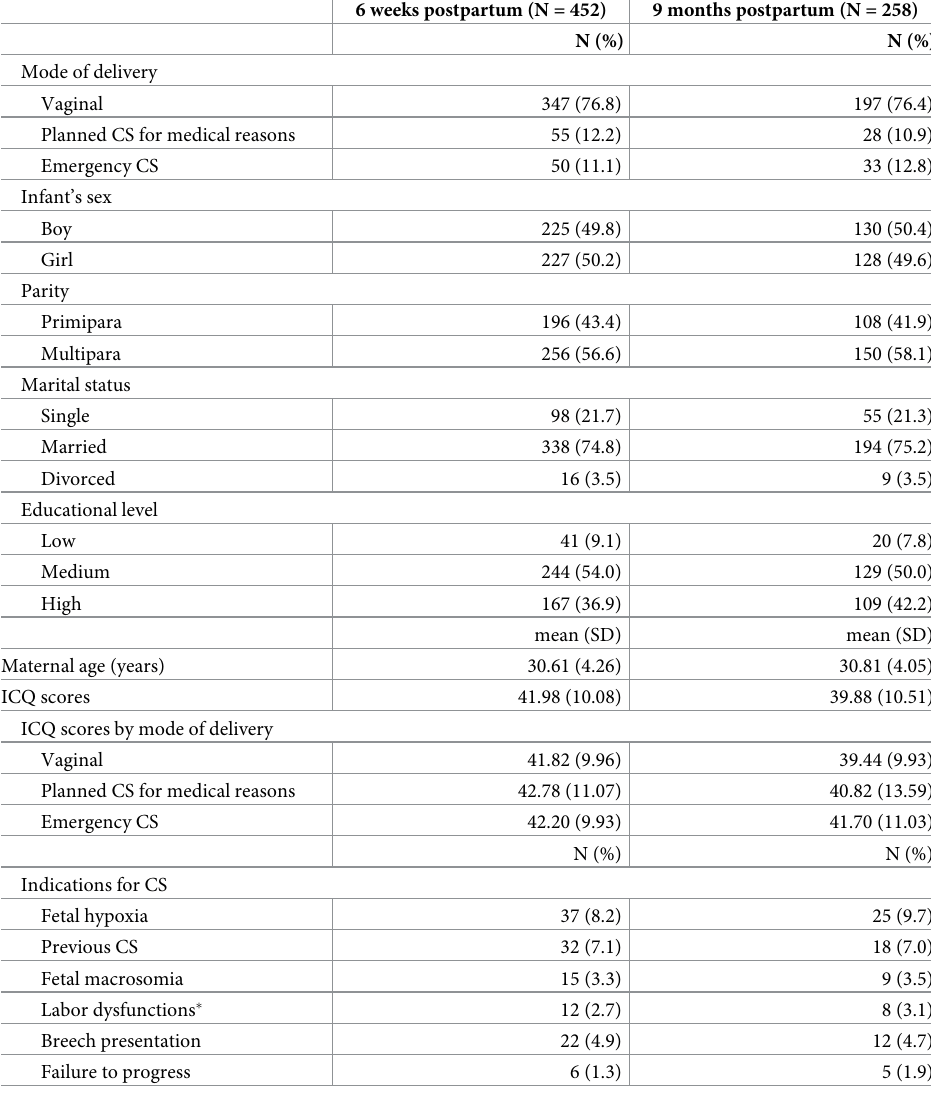
Table 1. Characteristics of the